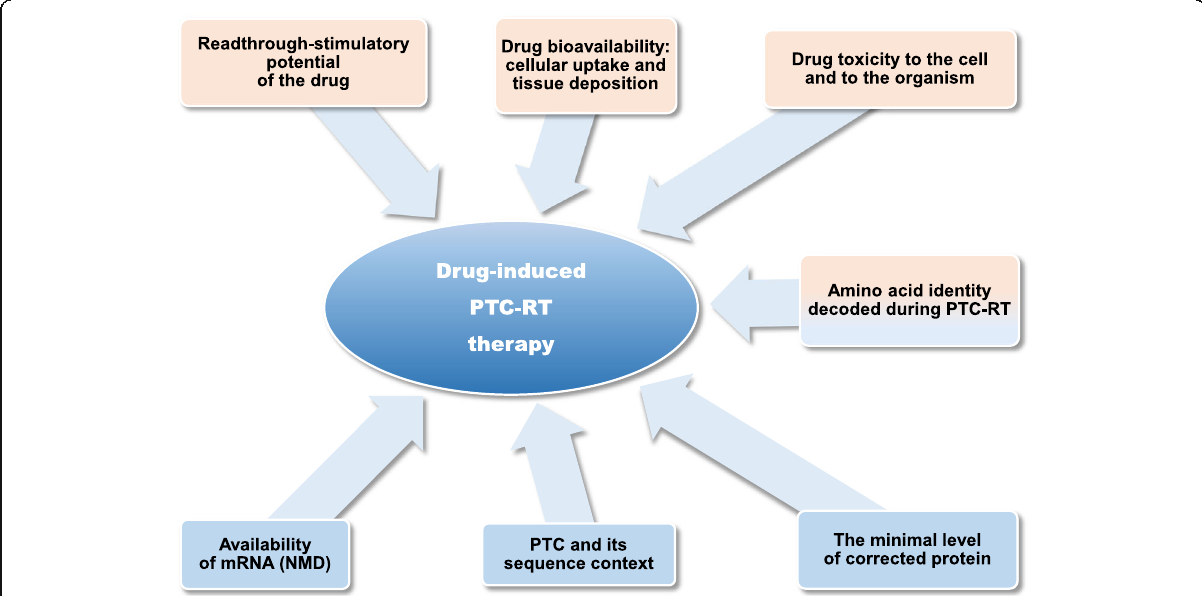
Fig. 2 Different problems associated with the drug-stimulated PTC-RT therapy. Upper part – problems associated with the PTC-RT- stimulating drugs. Lower part – problems associated with the biology of PTC-RT process